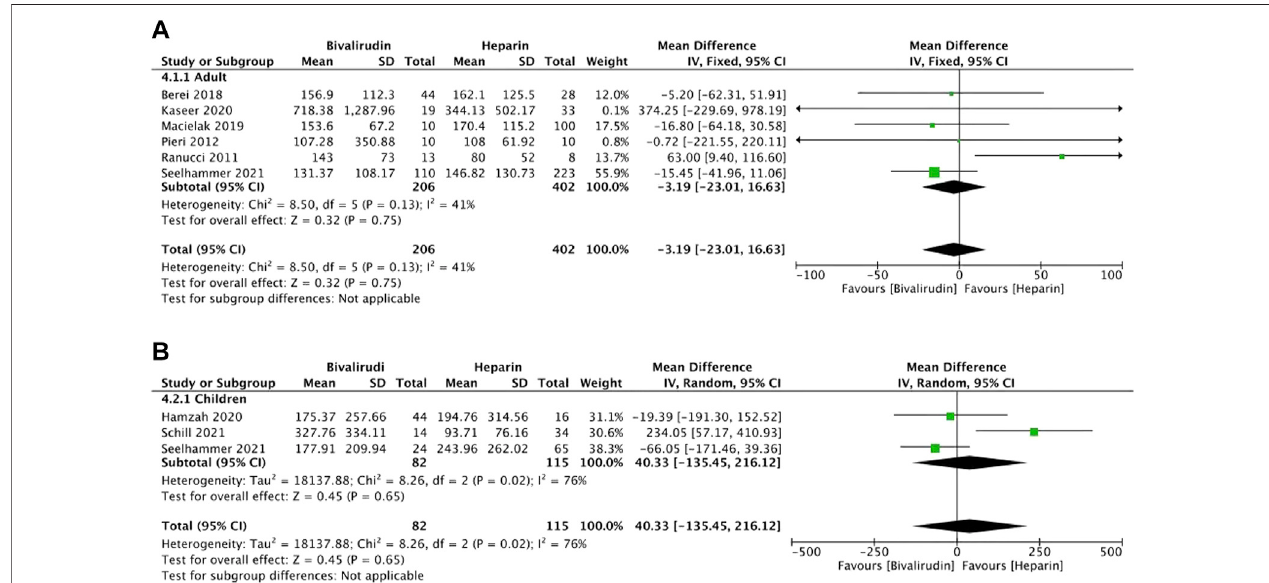
FIGURE 5 | The ECMO duration between the bivalirudin group and the heparin group. (A) adult group; (B) children group.